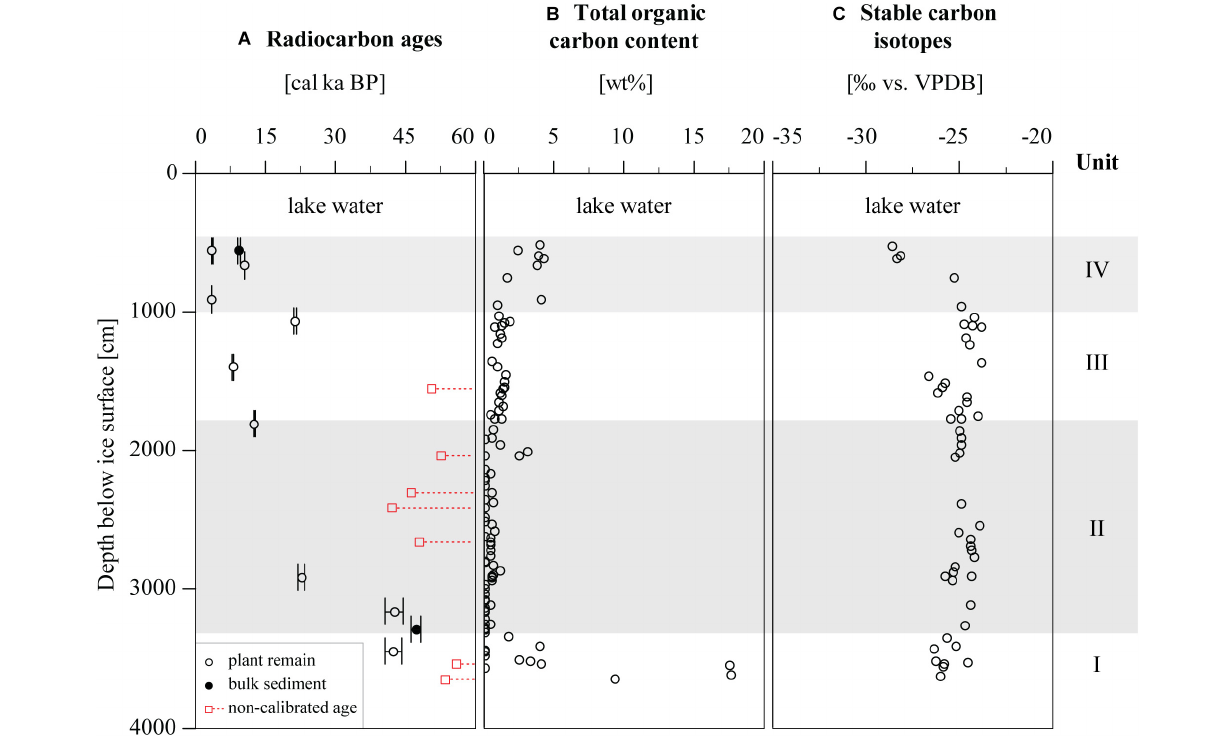
FIGURE 2 | Radiocarbon ages and biogeochemical parameters of Goltsovoye Lake sediment core PG2412. (A) Calibrated radiocarbon ages (open circles: plant remains dated, closed circles: bulk sediment dated, red circles: non-calibrated infinite ages), (B) total organic carbon content and (C) stable carbon isotopes. Units indicated on the